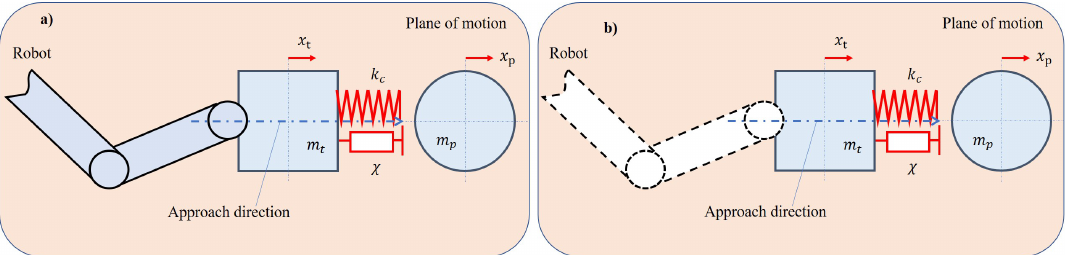
Figure 4. Non-instantaneous impacts. ( a ) A tool rigidly fixed to the robot; ( b ) a tool decoupled from the